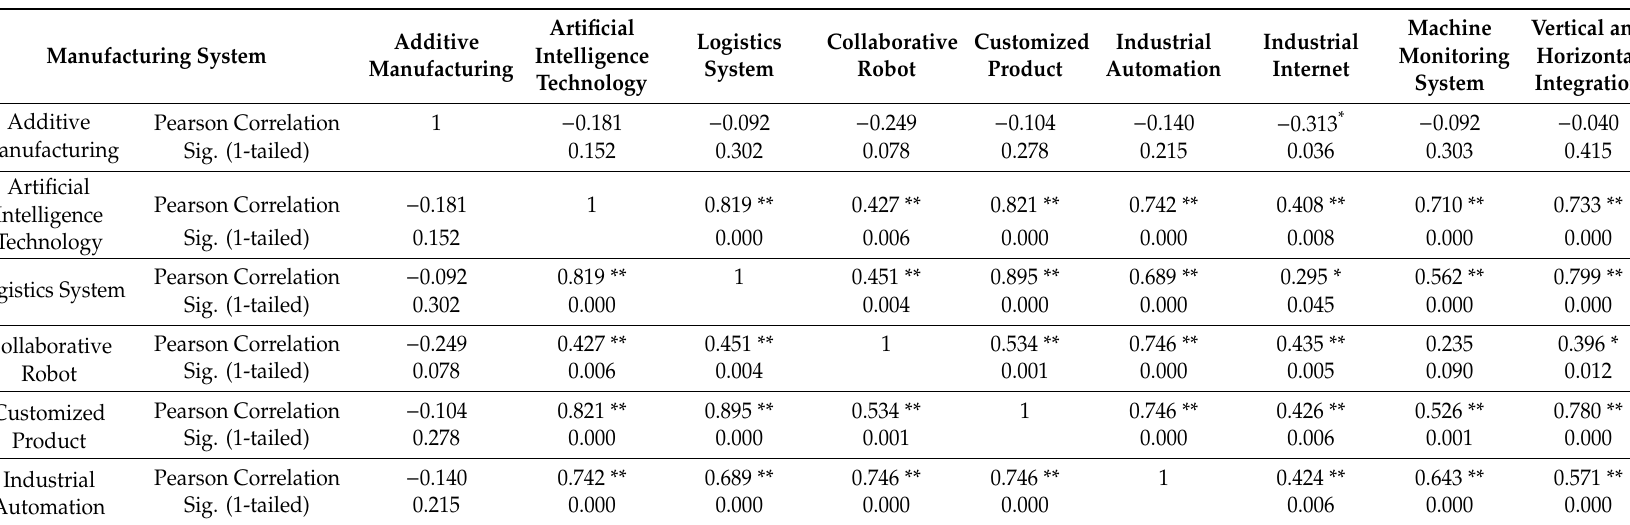
Table A3. Pearson’s